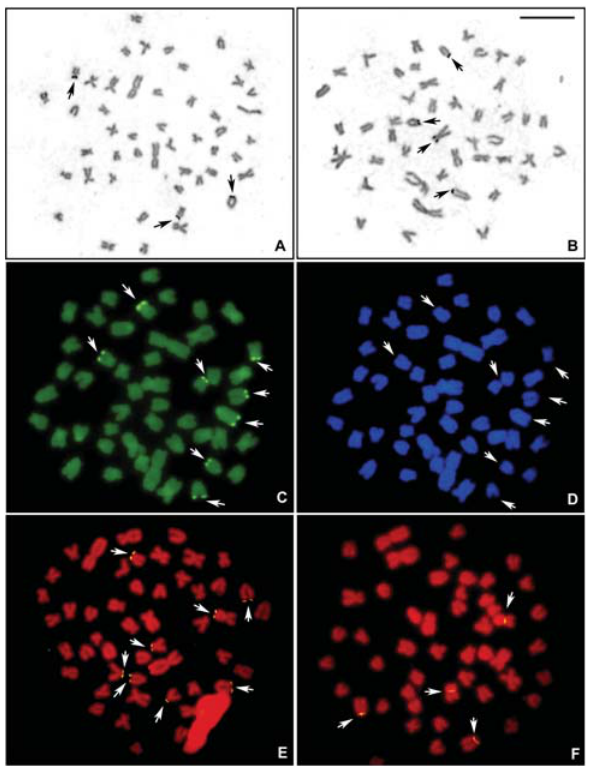
Figure 4 - Metaphases of the karyotypic form C (unidentified species of the Astyanax scabripinnis species complex) evidencing (A, B) the Ag- NOR bearing chromosomes; (C) Chromomycin A 3 positive or GC-rich sites; (D) sequential DAPI negative or AT-negative sites; (E) the 18S rDNA sites; and (F) the 5S rDNA sites. Bar represents 10 μ